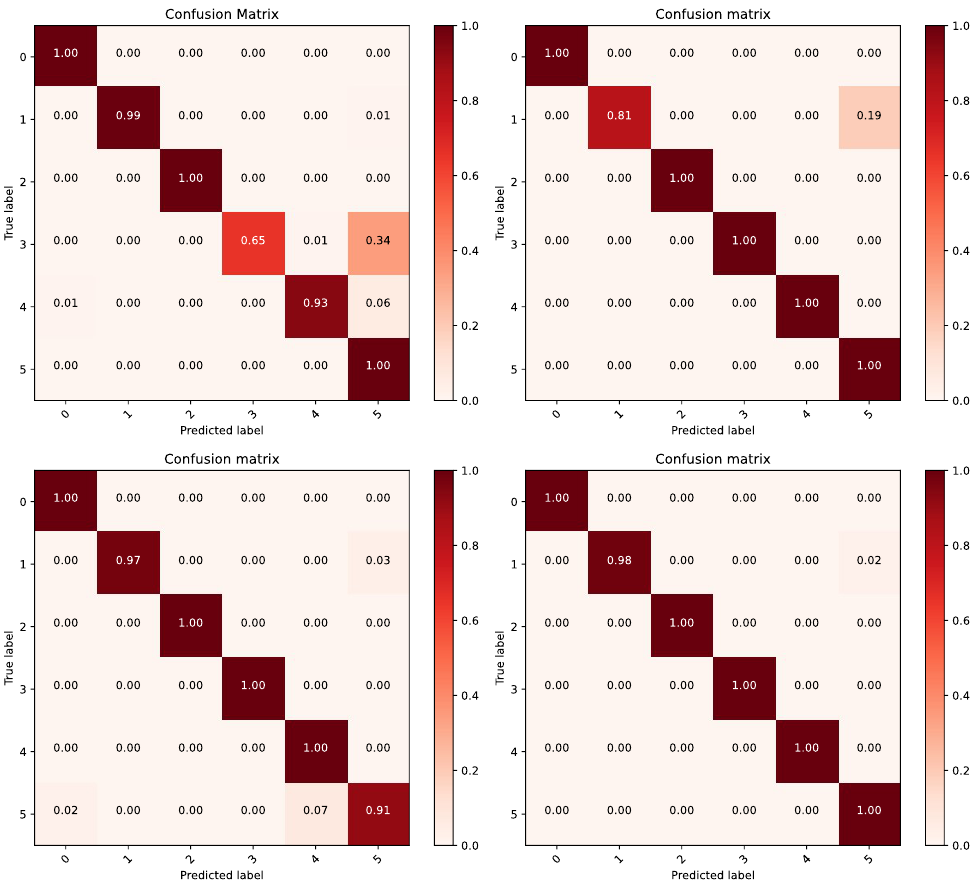
Figure 19. The confusion matrix of the four deep learning